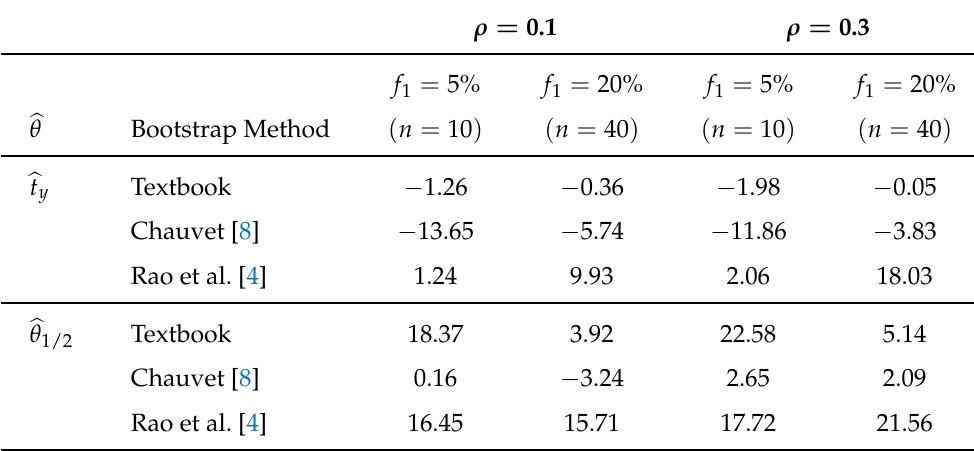
Table 6. Monte Carlo percent RB of the bootstrap variance estimators to estimate the variance of the point estimator based on 3000 samples selected according to IPPS/SRSWOR.